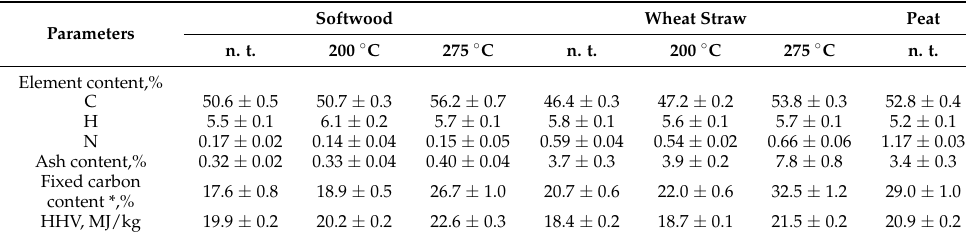
* the residual weight of biomass at 650 ◦ C determined by TG analysis in argon media and corrected on dry ash-free